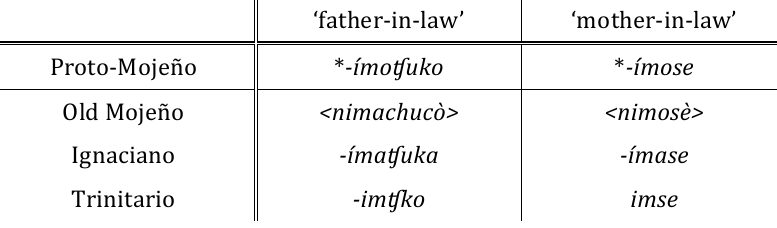
Table 4. Etymologies for PM ‘father-in-law’ and ‘mother-in-law’